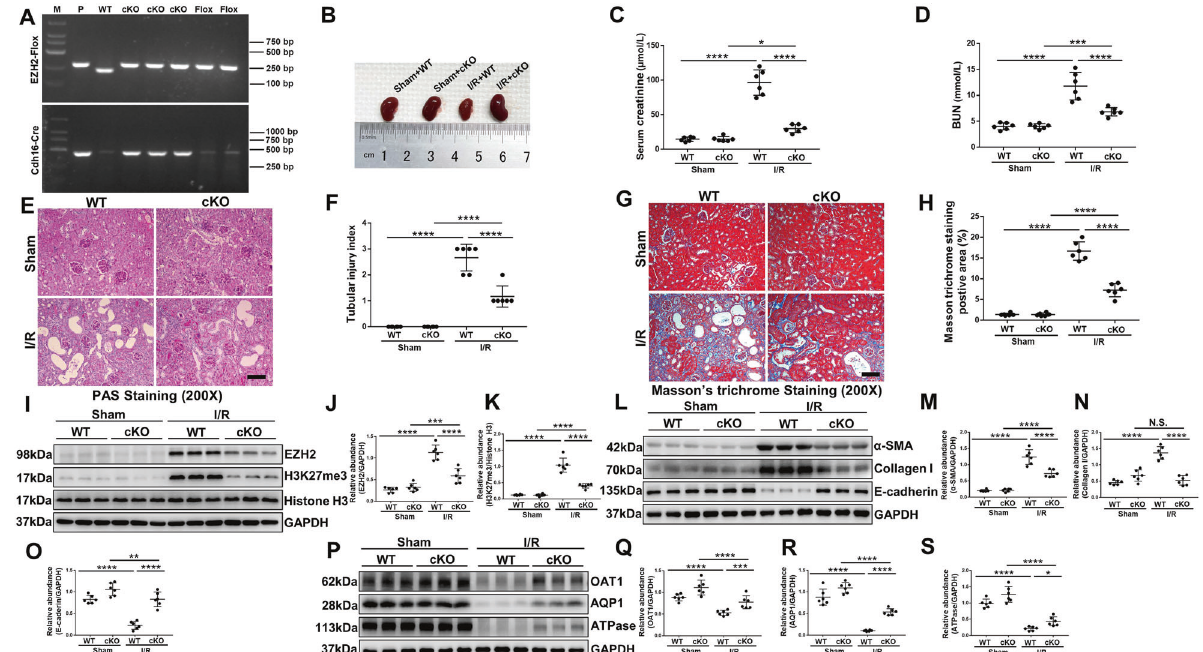
Fig. 2 EZH2 conditional knockout protects against renal dysfunction, suppresses renal fi brosis and loss of TEC transporters in I/R induced AKI-to-CKD transition mouse model. The mouse model of AKI-to-CKD transition induced by I/R was established by clipping the bilateral renal arteries of mice for 30 min, and the animals were observed and fed for 4 weeks after operation. A Generation of conditional knockout mice in which EZH2 was speci fi cally ablated in tubular epithelial cells by using Cre-LoxP recombination system. Genotyping was con fi rmed by tail preparation and PCR at 2 weeks of age. B Photograph showed the size, color, and texture of kidney in each group. C Serum creatinine of the mice in different groups. D Blood urea nitrogen (BUN) of the mice in different groups. E Photomicrographs showed the PAS staining of the kidneys. F Morphologic change of tubular injury was scored on the basis of PAS staining described in the Method section. G Photomicrographs showed the Masson ’ s trichrome staining of the kidneys. H The graph showed the positive areas (blue) of Masson ’ s trichrome staining. I Kidney tissue lysates from I/R mice were subjected to immunoblotting analysis with speci fi c antibodies against EZH2, H3K27me3, Histone H3, and GAPDH. J , K Expression levels of EZH2 and H3K27me3 in different groups were quanti fi ed by densitometry and normalized with GAPDH and Histone H3 respectively. L Kidney tissue lysates from I/R mice were subjected to immunoblotting analysis with speci fi c antibodies against α -SMA, Collagen I, E-cadherin, and GAPDH. M – O Expression levels of α -SMA, Collagen I, E-cadherin in different groups were quanti fi ed by densitometry and normalized with GAPDH. P Kidney tissue lysates from I/R mice were subjected to immunoblotting analysis with speci fi c antibodies against OAT1, AQP1, ATPase, and GAPDH. Q – S Expression levels of OAT1, AQP1, and ATPase in different groups were quanti fi ed by densitometry and normalized with GAPDH. Data were expressed as means ± SEM. * P < 0.05; ** P < 0.01; *** P < 0.001; **** P < 0.0001. N.S., statistically not signi fi cant, with the comparisons labeled. All scale bars = 50 μ